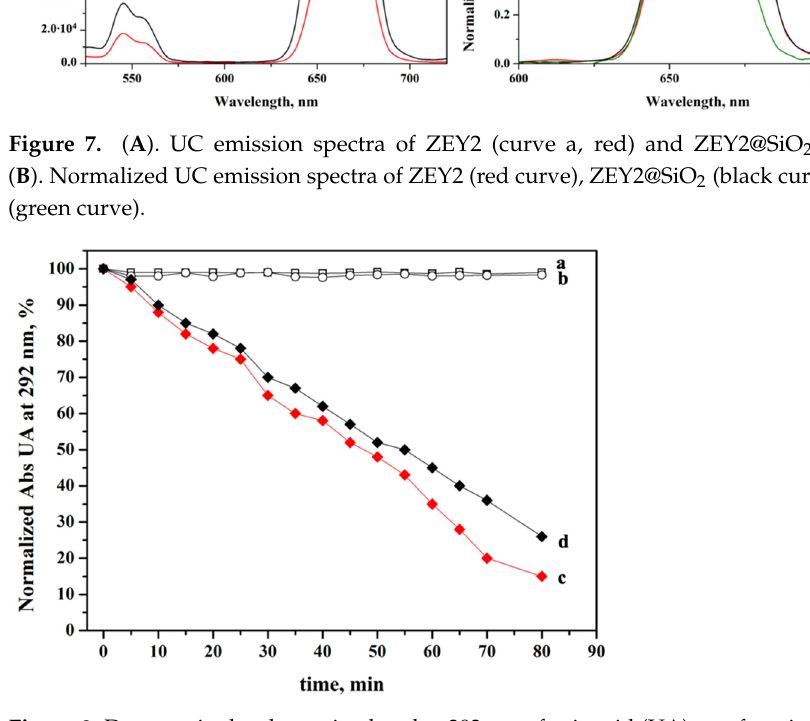
Figure 8. Decrease in the absorption band at 292 nm of uric acid (UA) as a function of the irradiation time, in the presence pristine ZEY2 (curve a, black empty squares), ZEY2@SiO2 (curve b, black empty circles), and ZEY2-Ver under conventional irradiation (curve c, red full squares), or upconversion irradiation (curve d, black full squares).